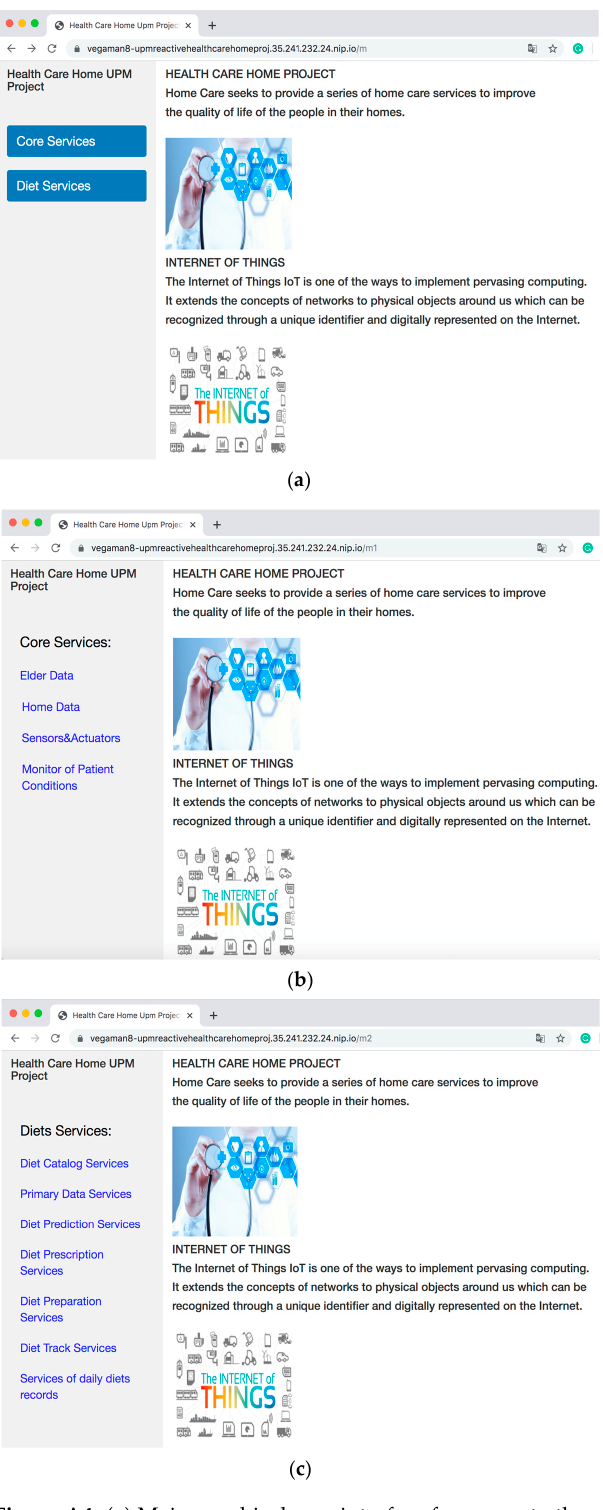
Figure A4. ( a ) Main graphical user interface for access to the services of the e-health system. ( b ) The graphical user interface for access to the microservices of the system core. ( c ) The graphical user interface for access to diet management